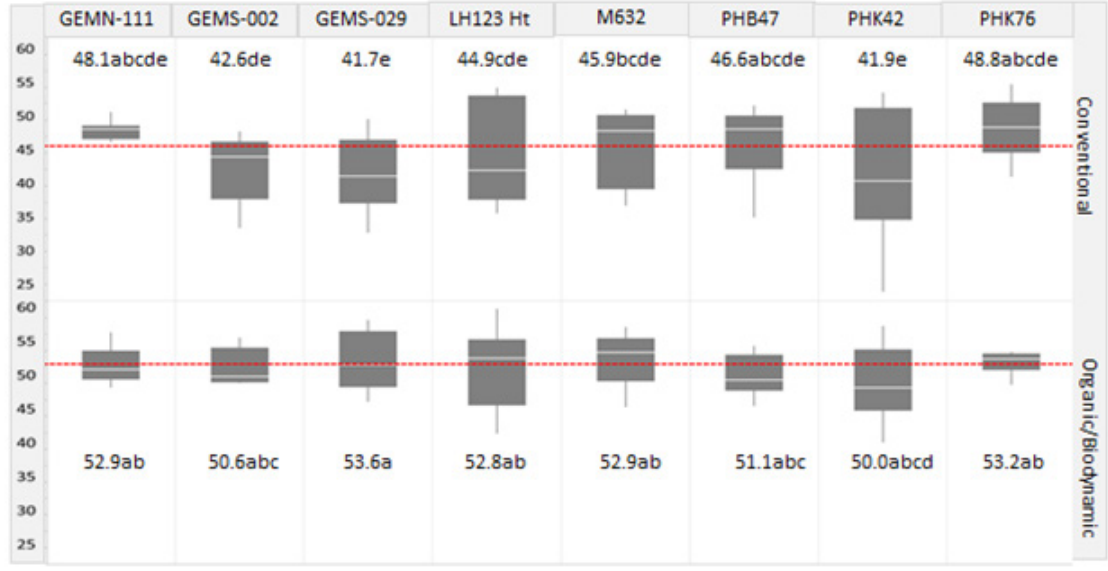
Figure 4: Spad meter chlorophyll scores presented in the form of box and whisker graphs. Data is for inbreds and breeding lines grown and selected under conventional and organic/biodynamic programs. The boxes comprise the first, second, and third quartiles of the data distribution and show the mode values. Whisker lines above and below the boxes indicate the range in the data. Red lines indicates the overall mean value for the conventional source cultivars (45.1) and for the organic/biodynamic source (52.1). LS means and letters indicating significance of differences at P = 5% are next to their respective boxes